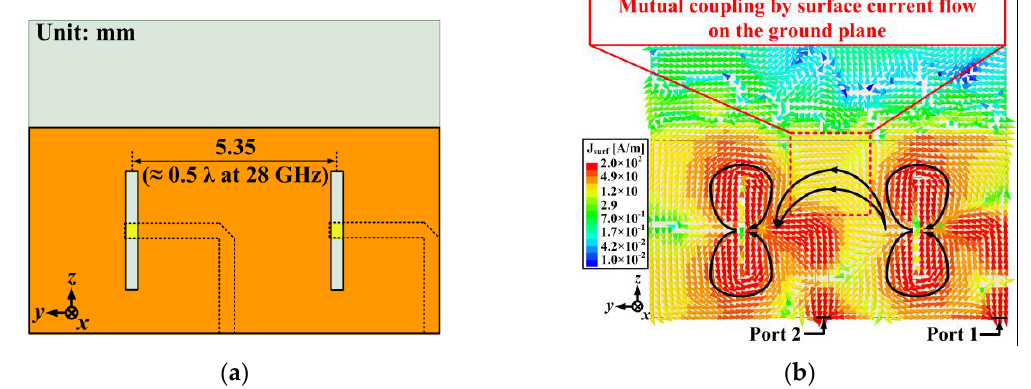
Figure 3. A 1 × 2 array antenna without directors: ( a ) top view, and ( b ) simulated surface current distribution at 28 GHz.